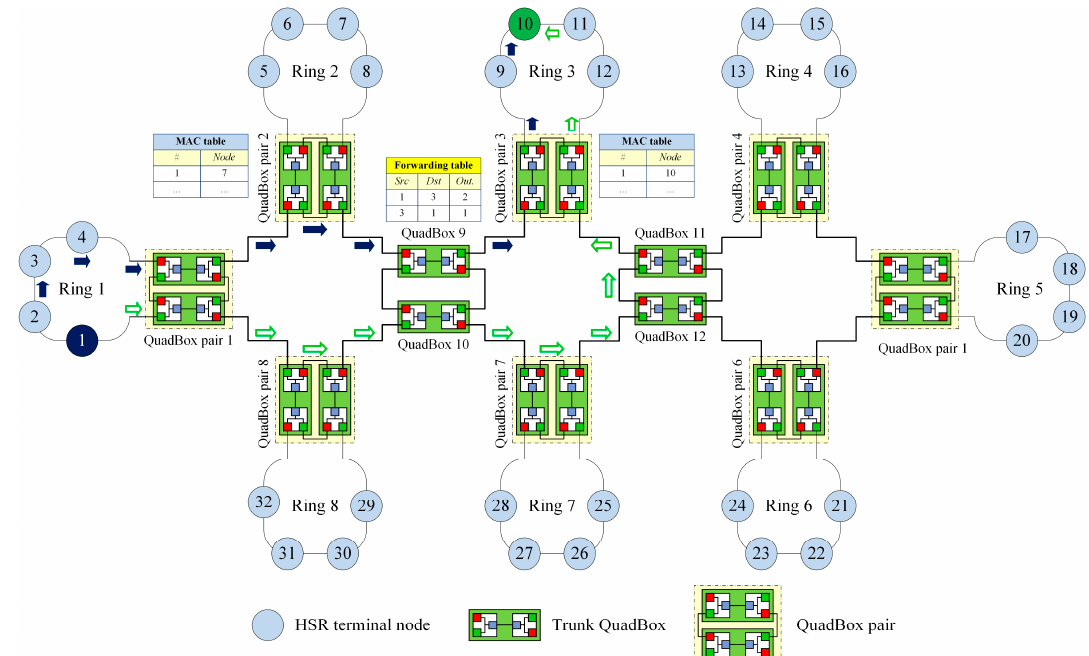
Figure 6. The process of forwarding a unicast frame using the DSP-based approach.